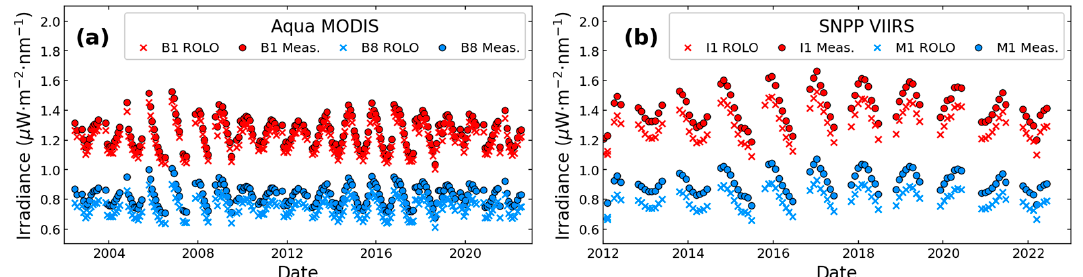
Figure 7. Comparison of the measured lunar irradiance (circles) and ROLO model predicted irradi- ance (x’s) for ( a ) Aqua MODIS bands 1 and 8 and ( b ) SNPP VIIRS bands I1 and M1.